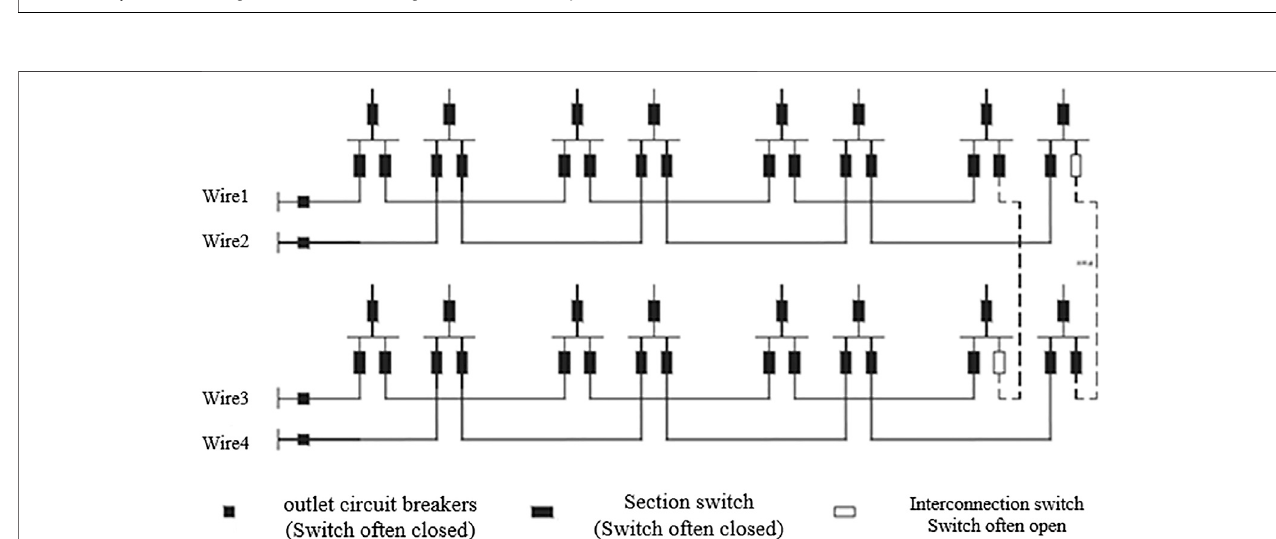
FIGURE 3 | Schematic diagram of cable double ring network connection (ring network room